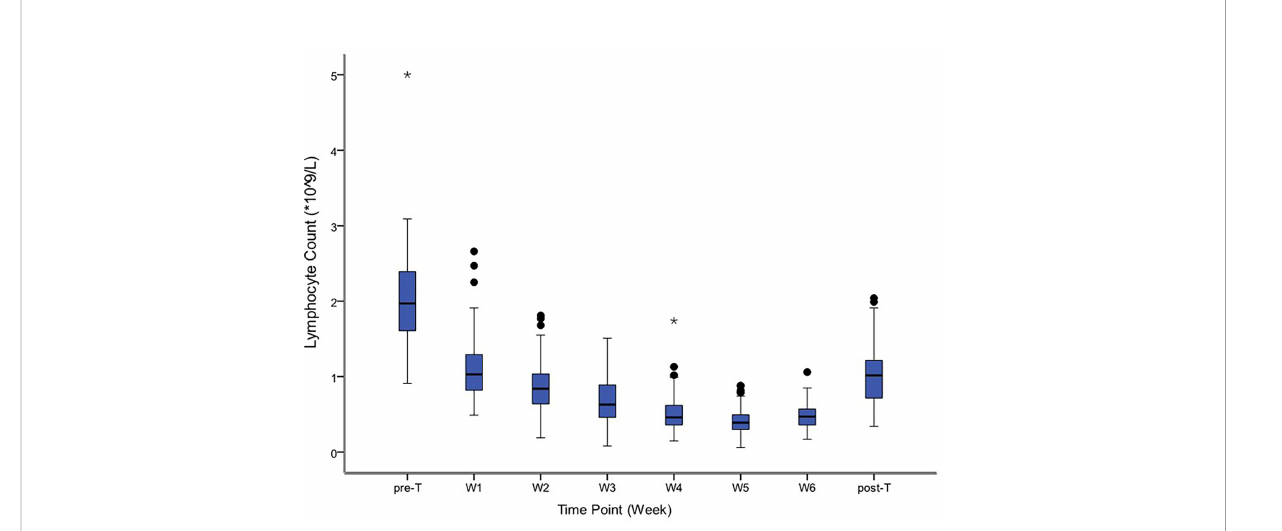
FIGURE 2 Distribution of absolute lymphocyte counts before, during and after treatment. The symbol * means outlier.